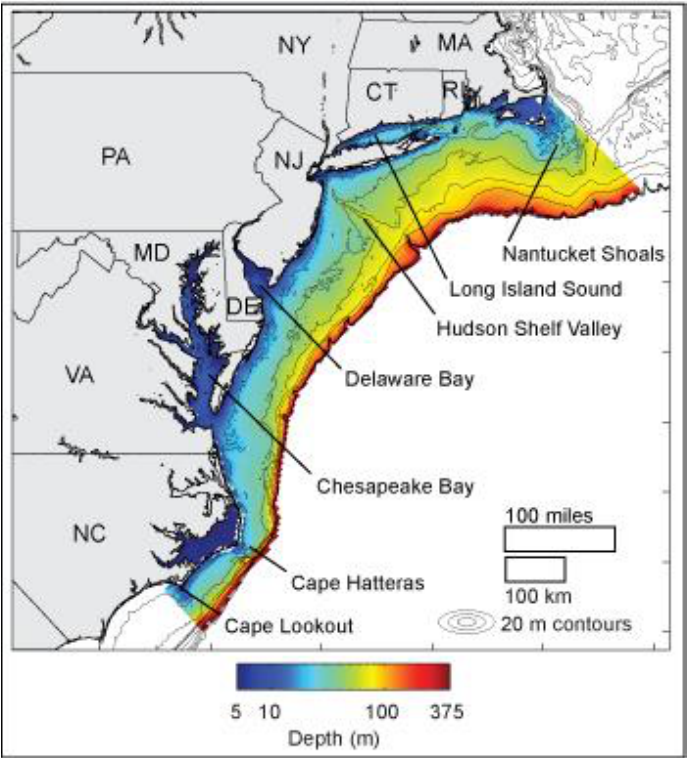
Figure 4. The Virginia-Maryland coastal region is roughly in the center of the Middle Atlantic Bight and includes the Chesapeake Bay. The width of the continental shelf here is 125 km. Source: U.S. Geological Survey Public Domain Image.